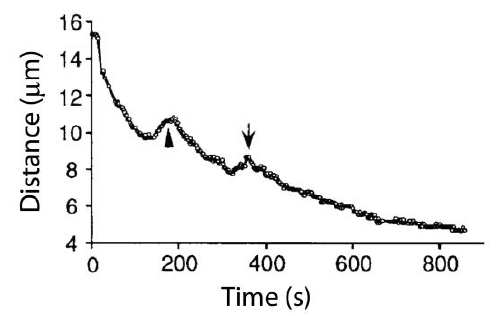
Figure 3. Example of kinetochore directional instability during anaphase A in a newt lung cell. Anaphase A chromosome-to-pole movement of the kinetochore is interrupted by transient reversals in directionality. This graph is reprinted from [12], and is displayed under the terms of a Creative Commons License (Attribution-Noncommerical-Share Alike 3.0 Unported license, as described at